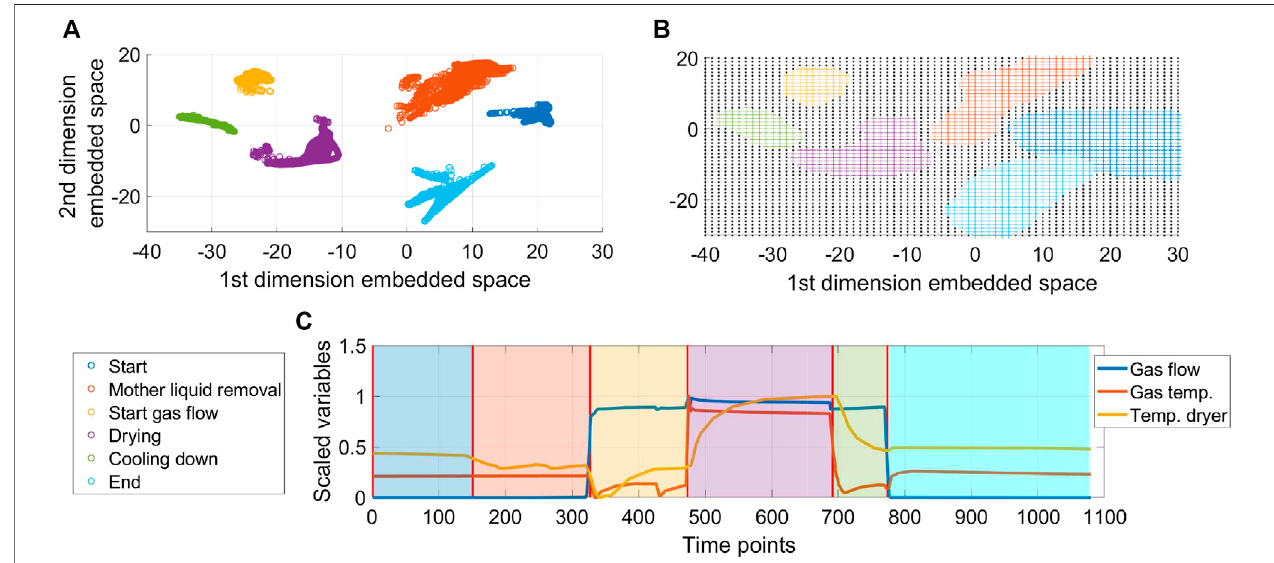
FIGURE 14 | Results on the phase identi fi cation for the centrifuge drying process.